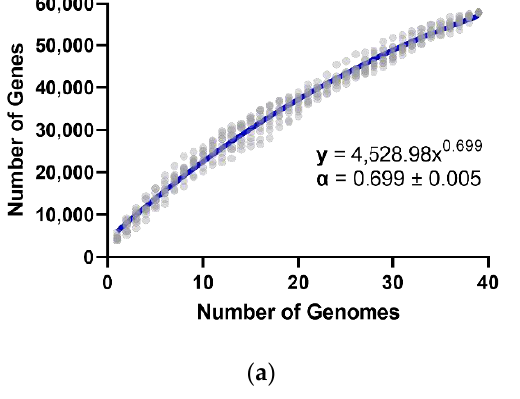
Figure 6. Estimation of the pan-genome for the genus Gordonia . ( a ) The number of total genes is plotted as a function of the number of genomes based on ten subsamples per genome. ( b ) The num- ber of new genes is plotted as a function of the number of genomes based on ten subsamples per genome.